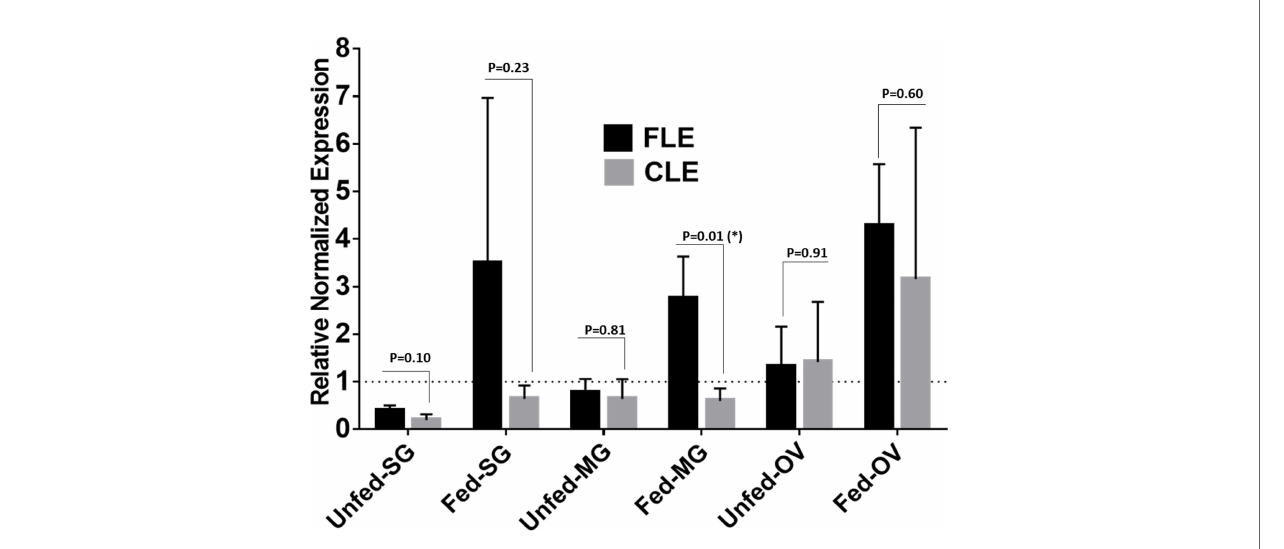
FIGURE 10 | qPCR-based relative quanti fi cation of FLE and CLE in fi eld-collected tick tissues (salivary gland, midgut and ovary) from Delaware. All the expressions shown are relative to actin. Expression of actin has been shown as 1 (dotted line). Statistically signi fi cant comparisons are indicated by * p ≤ 0.05). SG, salivary gland; MG, midgut; OV,